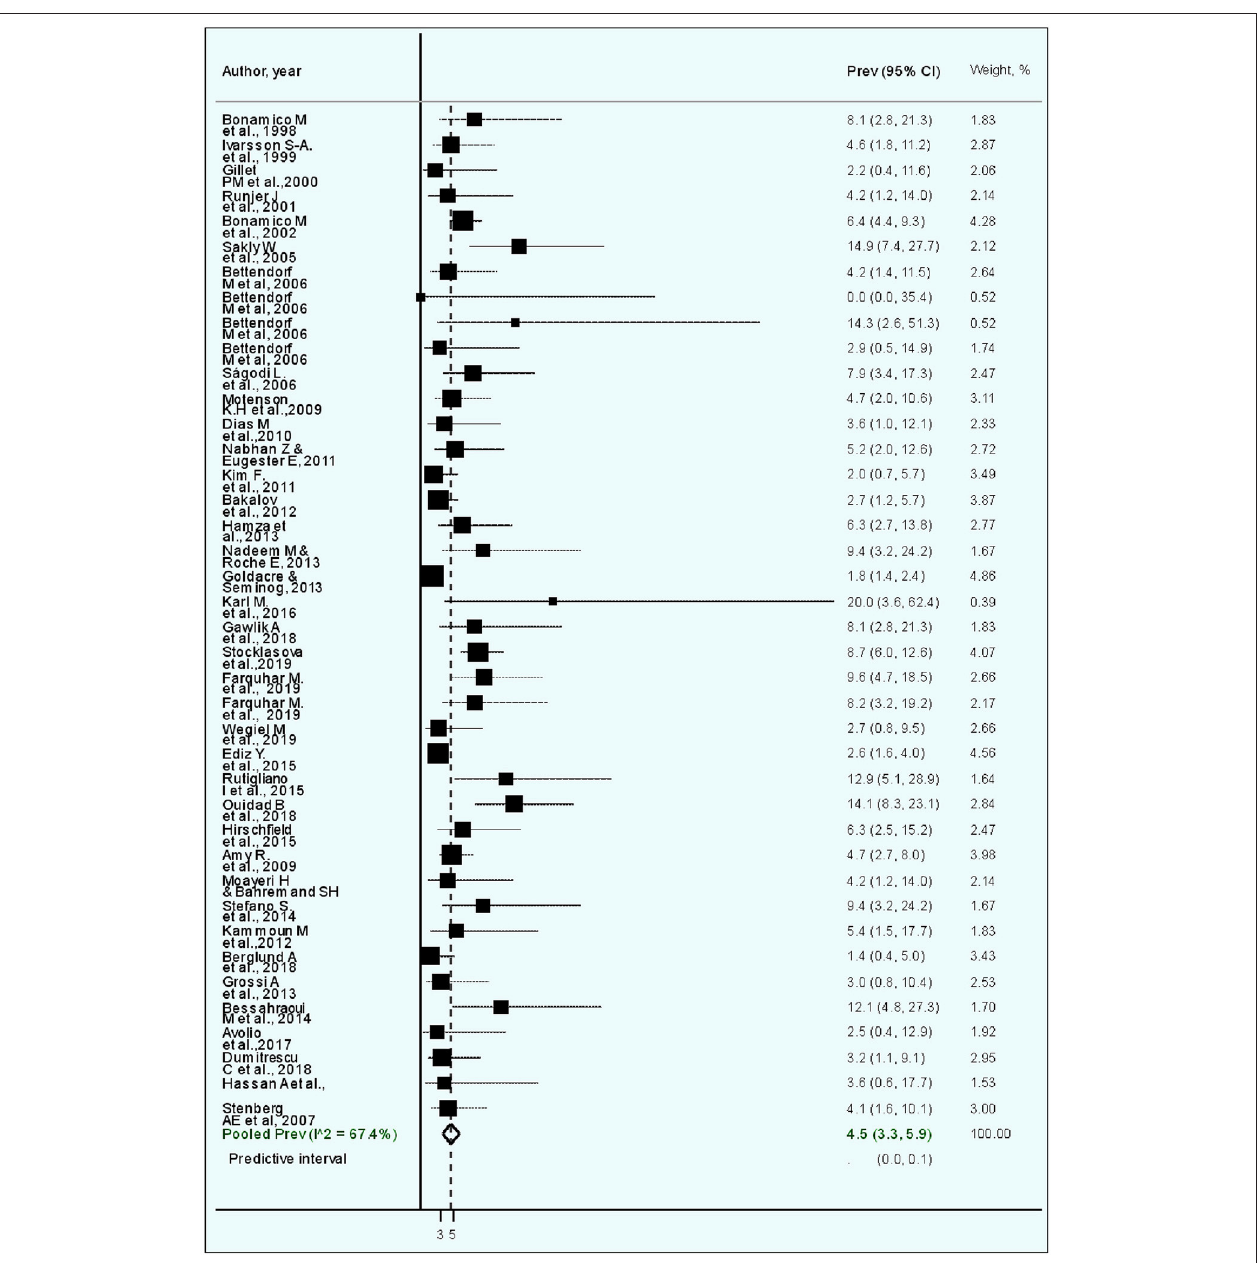
FIGURE 2 | Forest plot of the meta-analysis of studies on celiac disease in patients with Turner syndrome. The diamond is centered on the summary prevalence estimate, and the width indicates the corresponding 95% confidence interval (CI).